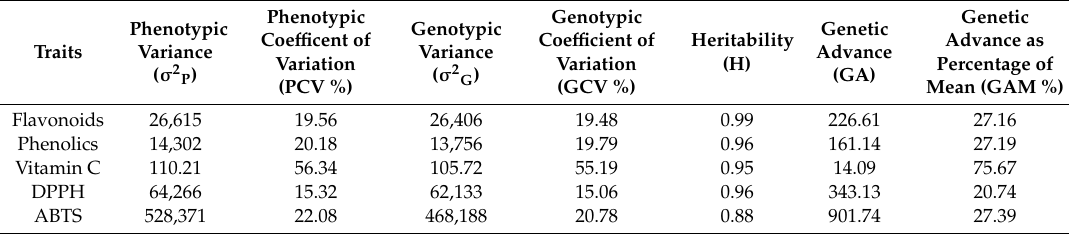
Table 4. Estimates of variance, heritability (H) and genetic advance of fruit phytochemical content and antioxidant activity in 30 blue honeysuckle